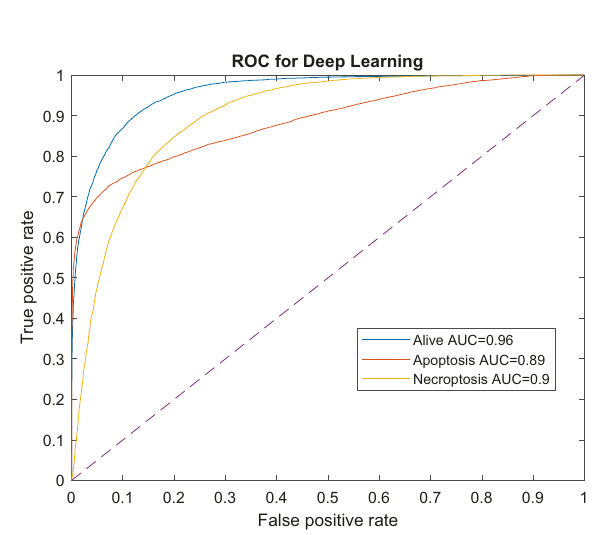
Fig. 5 Area under the curve represents a comparison between three categories (alive, apoptosis and necroptosis). Receiver operating characteristic (ROC) plot is shown with the true positive rate (or sensitivity) on the y -axis and the false positive rate on the x - axis (or speci fi city). The diagonal line in the middle indicates a random guess with an AUC of 0.50. From this graph, the classi fi cation performance of the three categories, are compared. The fi nal model functions best when discriminating alive cells (AUC = 0.96) compared to apoptosis and necroptosis (AUC 0.89 and 0.90 respectively). However, all three classi fi ers function noticeably better than the random guess at an AUC of